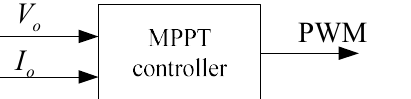
Figure 10. Controller structure of using the VWPOS.